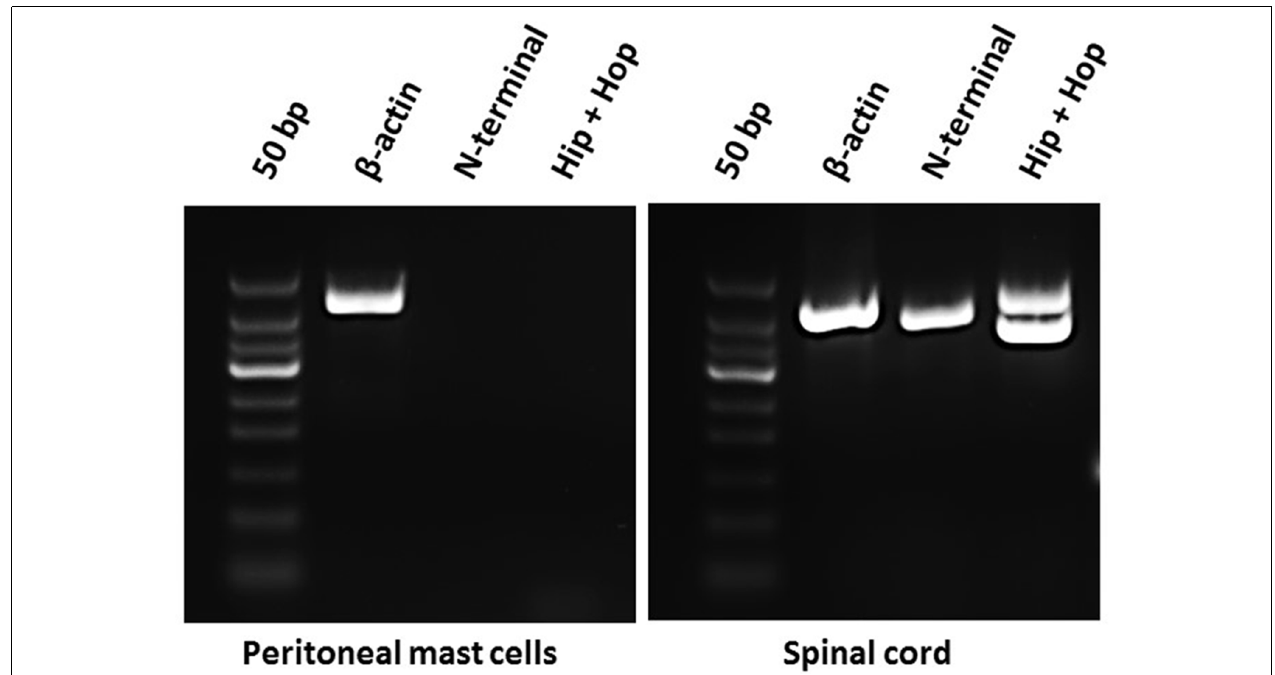
FIGURE 1 | Agarose gel electrophoresis showing the absence of mRNA-expression of PAC 1 -receptor splice variants in rat peritoneal mast cells (left) and their presence in rat spinal cord (right) using primers directed towards the N-terminal part of the PAC 1 -receptor (392 bp) and exon 14 and 15 of the Hop-Hop variant of the PAC 1 -receptor (upper amplicon 471 bp and lower 387 bp). Primers detecting β -actin (422 bp) was used as a positive control and was present in both tissues. The experiment was performed in peritoneal mast cells from three rats.